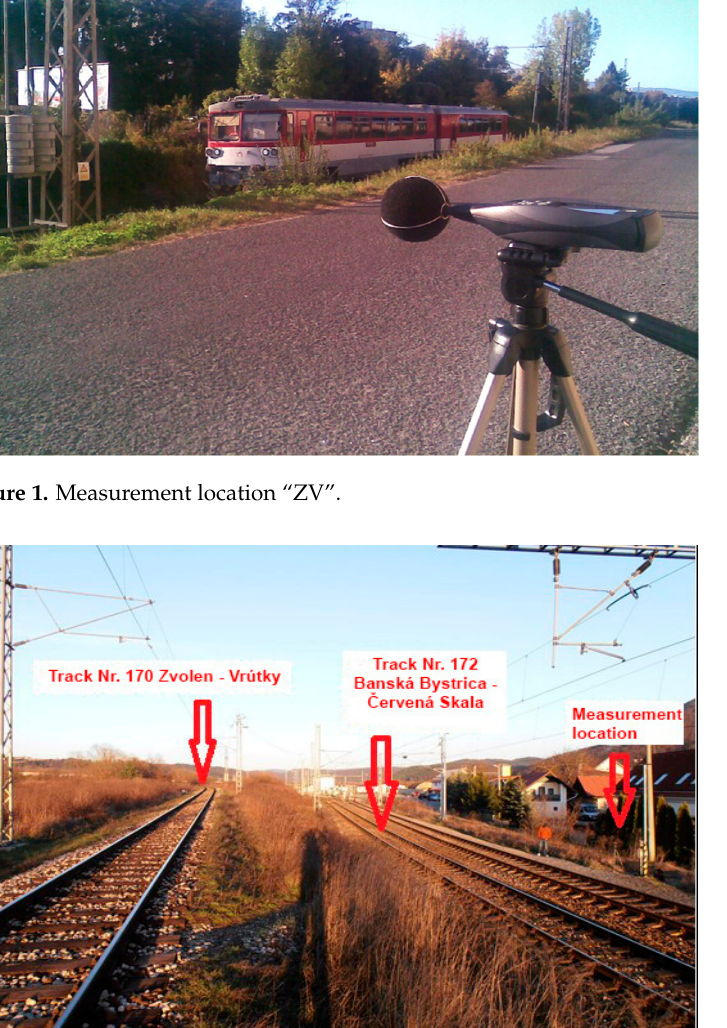
Figure 2. Measurement location